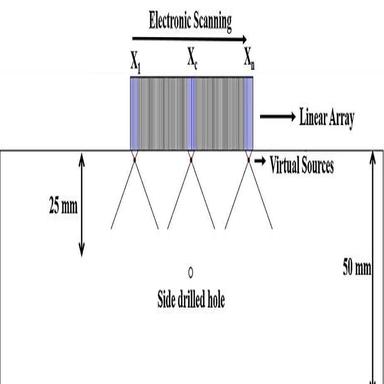
Data acquisition using PA-SAFT.